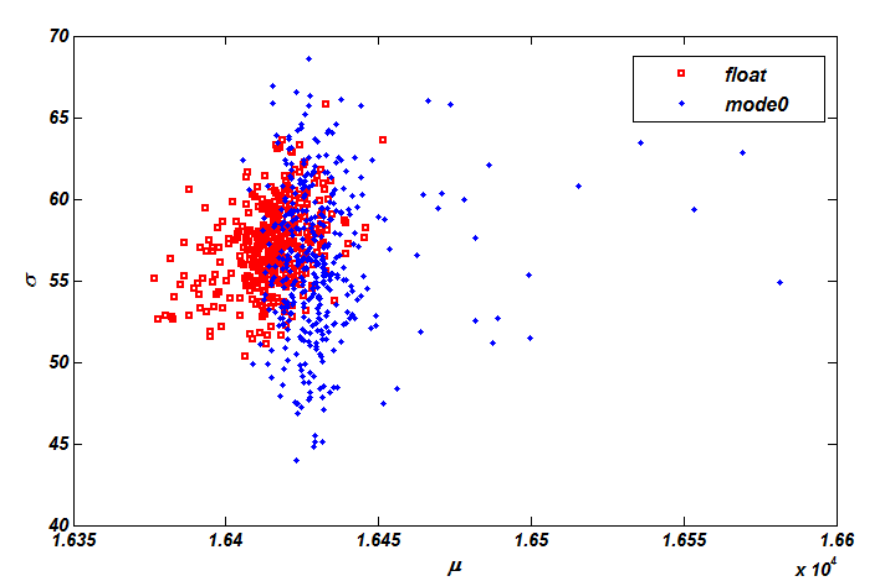
Figure 6. Noise level of float mode and